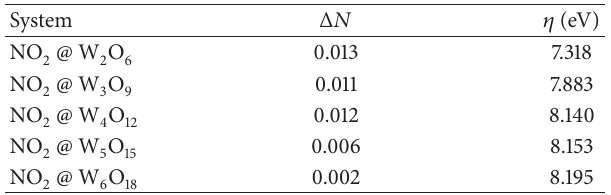
Table 3: Calculated energy of adsorption (in − eV) for NO ) ( WO 3 𝑛 complexes.